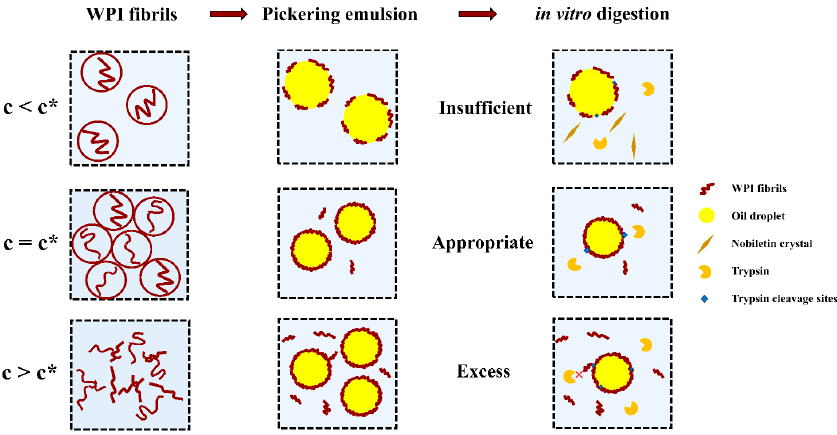
Figure 9. Schematic diagram of influence of WPI fibrils concentration on the emulsion structure and the bioaccessibility of nobiletin.